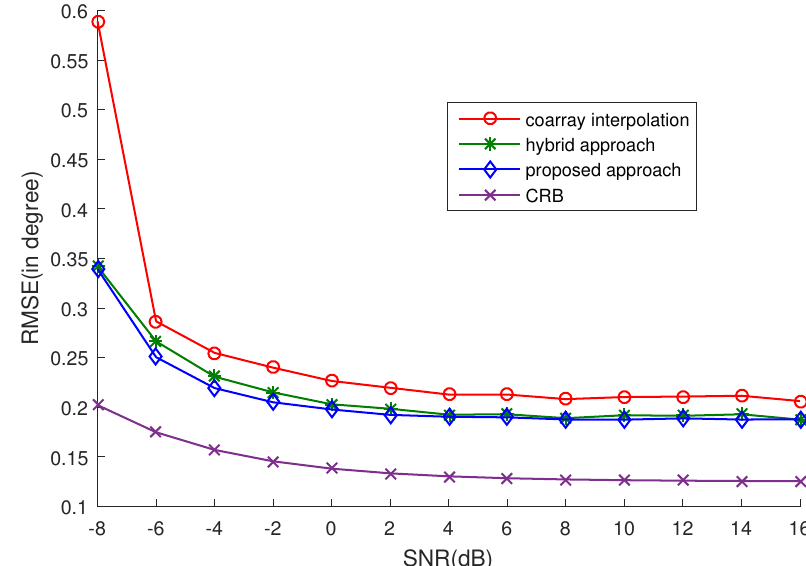
Figure 2. RMSE vs. SNR. Five hundred Monte Carlo trials are conducted and Q = 16 sources uniformly distributed in [ − 50 ◦ ,50 ◦ ] are considered. The number of snapshots is K = 500 and the selection of (cid:101) is listed in Table 2.